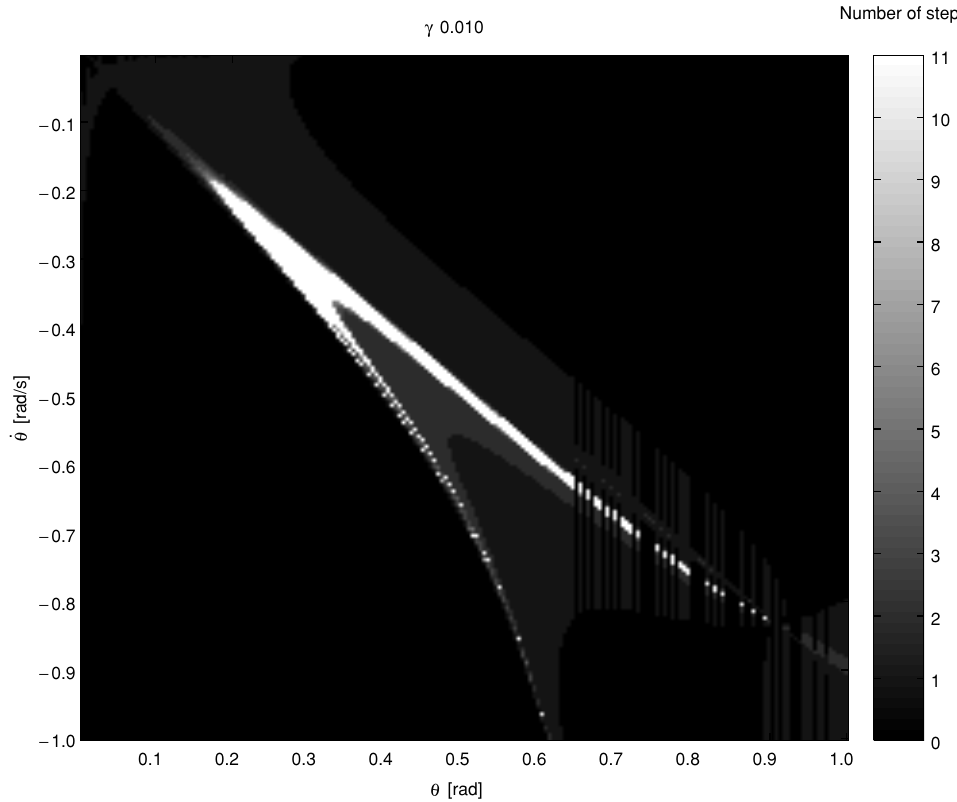
Figure 2 Stability of the kneeless walker in a noise-free 3D simulation environment. The simulation is started with a starting condition that only depends on the two parameters θ and ˙ θ . The colour of each pixel in the graph indicates how many steps the walker walks before falling. White indicates 11 steps; black, 0 steps. The simulation was stopped after 11 steps. Table 1 Parameters for the simulated walker